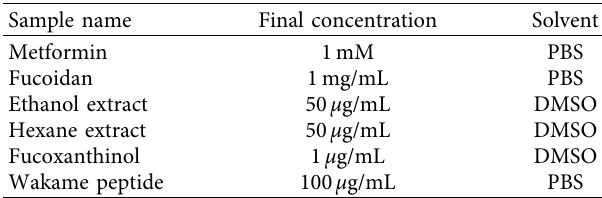
Table 1: Seaweed components used in cell culture